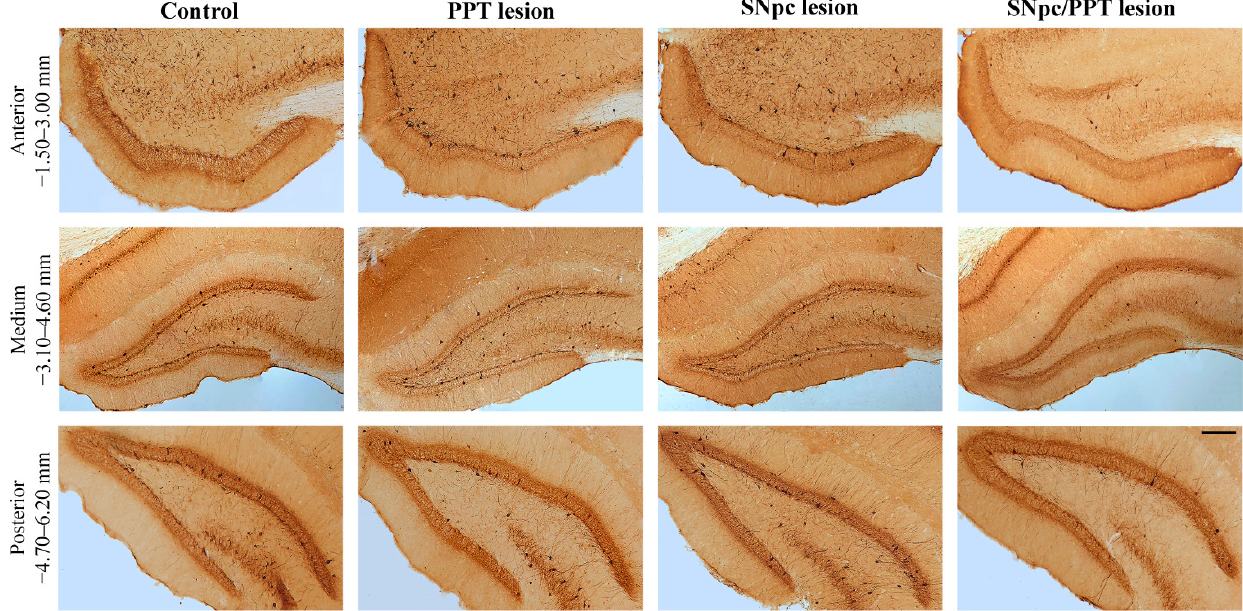
Figure 2. Individual examples of the PV+ interneurons alteration within DG in the distinct rat models of PD neuropathology. The typical examples of PV+ interneurons at three defined stereotaxic ranges throughout the overall antero-posterior dimension of DG (Anterior: − 1.50–3.00 mm posterior from bregma; Medium: − 3.10–4.60 mm posterior from bregma; Posterior: − 4.70–6.20 mm posterior from bregma) in the control rat (Control), the rat with PD cholinopathy (PPT lesion), the hemiparkinsonian rat (SNpc lesion), and the hemiparkinsonian rat with PD cholinopathy (SNpc/PPT lesion). Scale bar is 200 μ m.